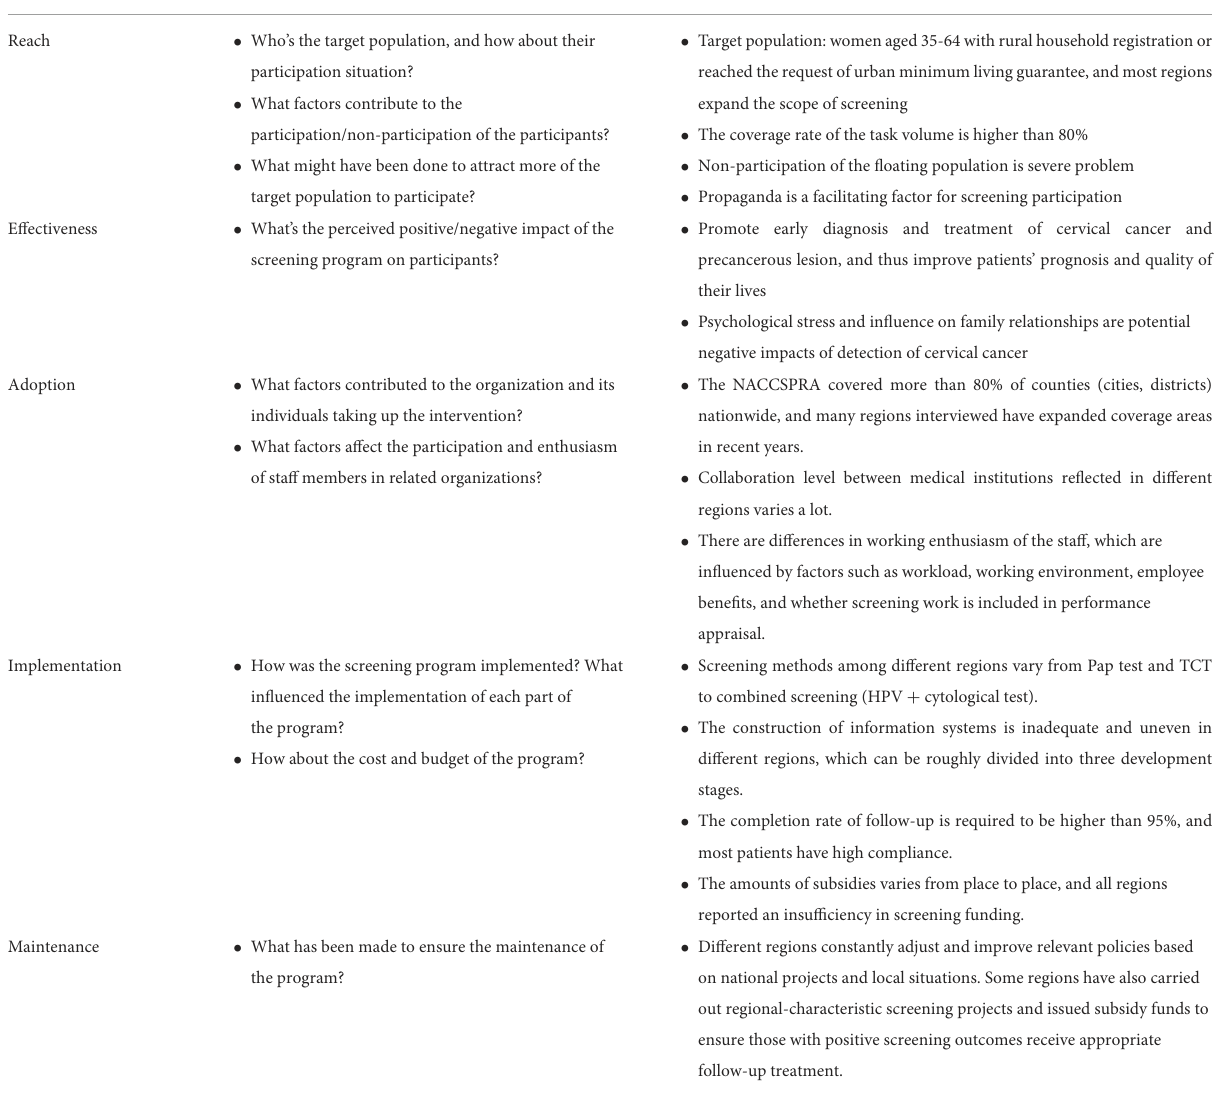
TABLE 1 Interview guideline and key findings based on RE-AIM